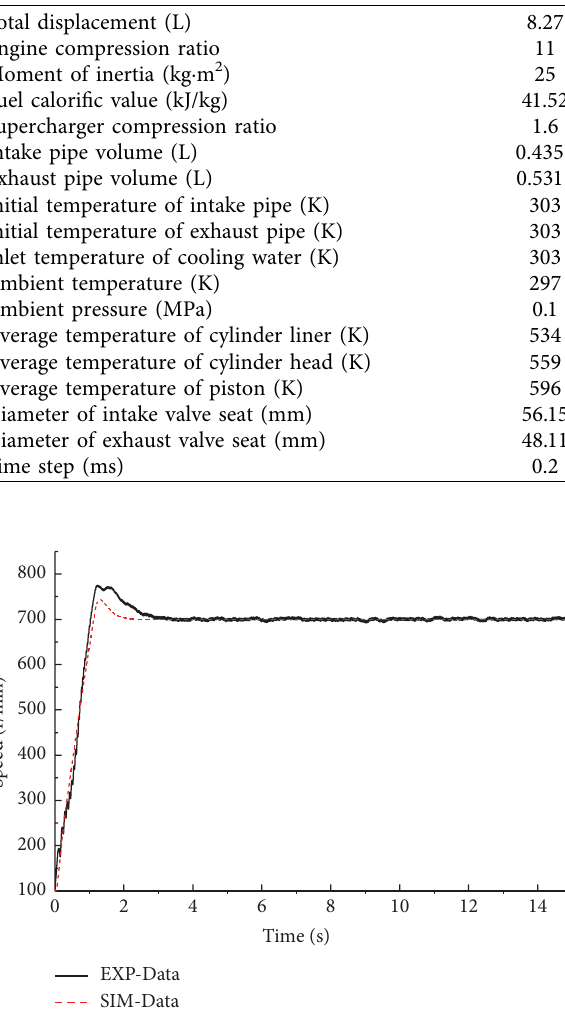
Figure 14: Simulation model verifcation during the engine start- up